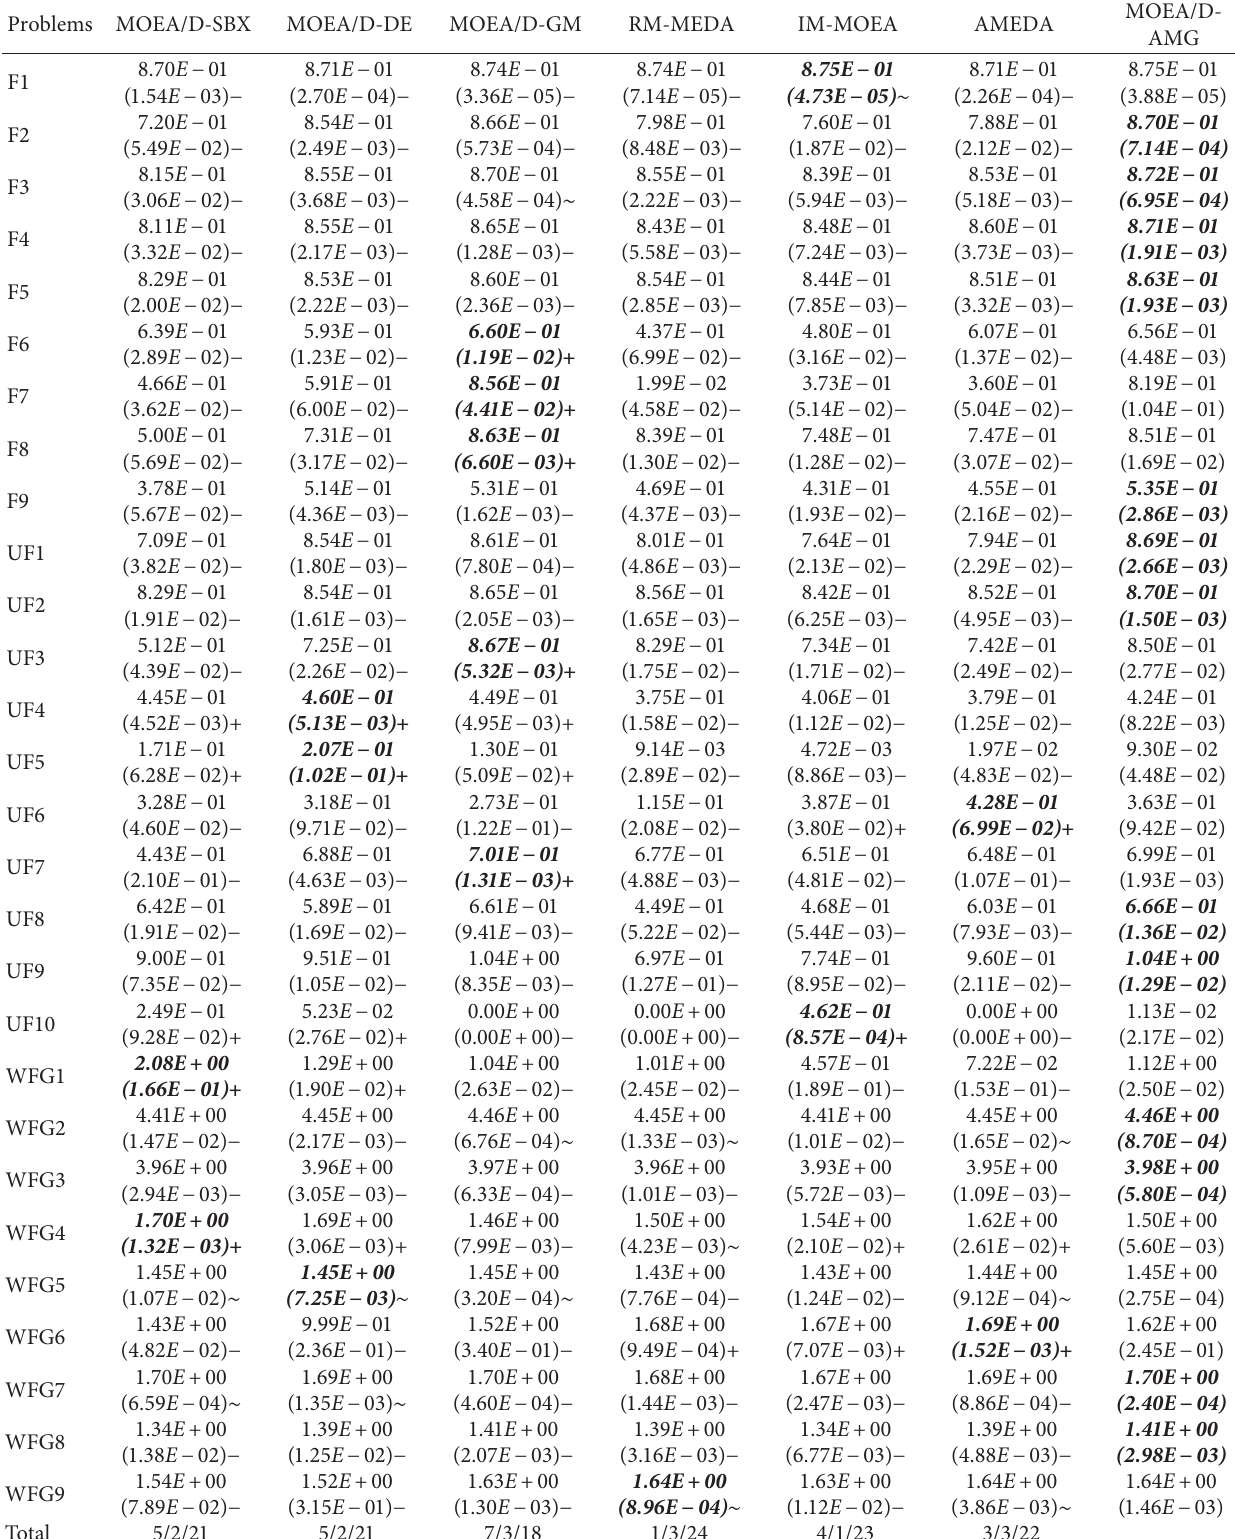
Table 2: Performance comparison of MOEA/D-SBX, MOEA/D-DE, MOEA/D-GM, RM-MEDA, IM-MOEA, AMEDA, and MOEA/D- AMG in terms of the average HV values and standard deviation on F, UF, and WFG